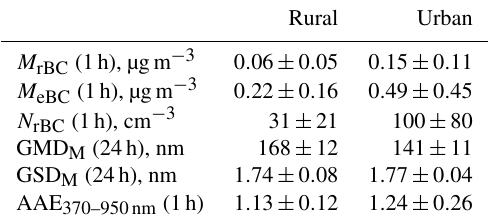
Table 1. Averages ± 1 σ (original averaging time in parentheses) for the urban and rural campaigns. rBC mass ( M ) and number ( N ) concentrations are from SP2 measurements, and eBC mass concentrations are from absorption at 880nm using a MAC of 7.77m 2 g − 1 . Mass-based geometric mean diameter (GMD M ) and geometric standard deviation (GSD M ) are from the rBC mass equiv- alent size distribution. rBC concentrations are not corrected for par- ticles outside the range of the instrument. Rural rBC concentra- tions are corrected for inlet losses. Absorption Ångström exponents (AAE) are calculated between absorption at 370 and 950nm. Rural